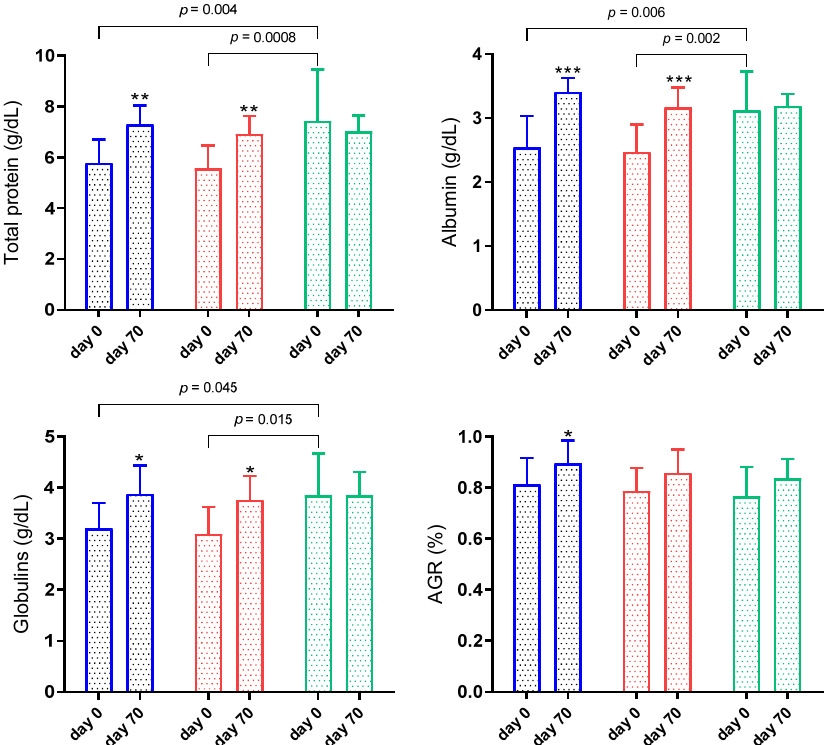
Figure 5. Total protein, albumin, globulin and albumin/globulin (AGR) ratio in sheep naturally infected by gastrointestinal nematodes and inserted in an integrated crop-livestock (ICL) system for 70 days. G1 (blue bar): faecal worm egg counts (EPG) higher than 5000 and packed cell volume (PCV) lower than 24%; G2 (red bar): EPG higher than 5000 and PCV higher than 24%; G3 (green bar): EPG lower than 5000 and PCV higher than 24%. Asterisks indicate significantly different from day 0. * p < 0.05; ** p < 0.01; *** p < 0.001. Table 1. Spearman correlation coefficients and significance between the different biomarkers studied and the faecal worm egg counts (EPG) in lambs infected by gastrointestinal nematodes inserted in an integrated crop-livestock (ICL) system for 70